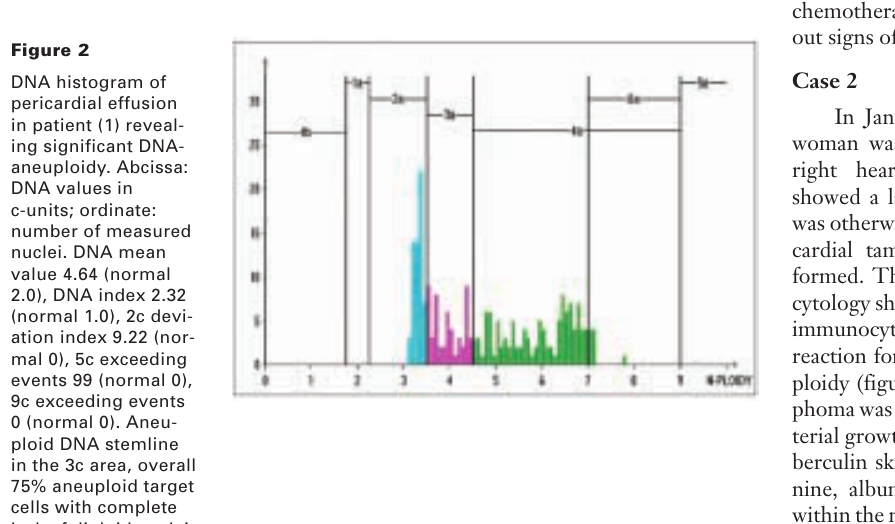
Pericardial fluid spec- imen of patient (1) revealing numerous highly atypical lym- phoid cells with high nuclear/cytoplasmic ratios, irregular nu- clear structure and large polymorphic nucleoli (Papanico-